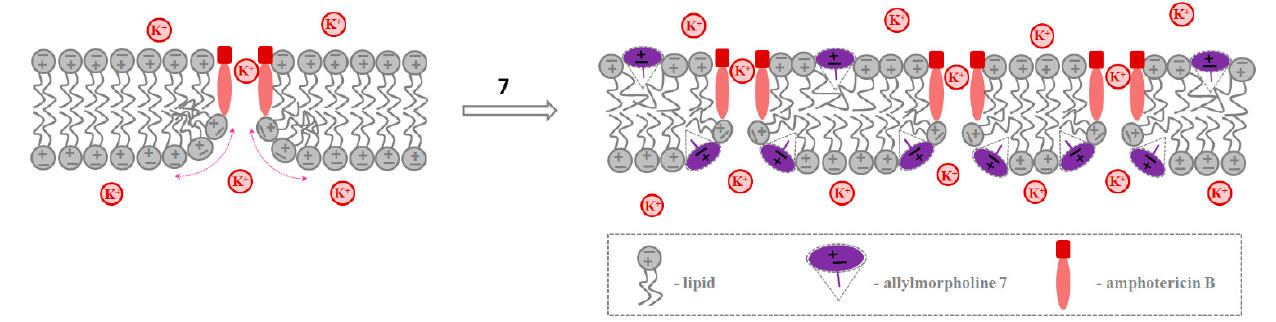
Figure 6. The schematic representations of the mechanisms of action of allylmorpholine 7 on the pore-forming activity of AmB via alterations in lipid-packing stress.